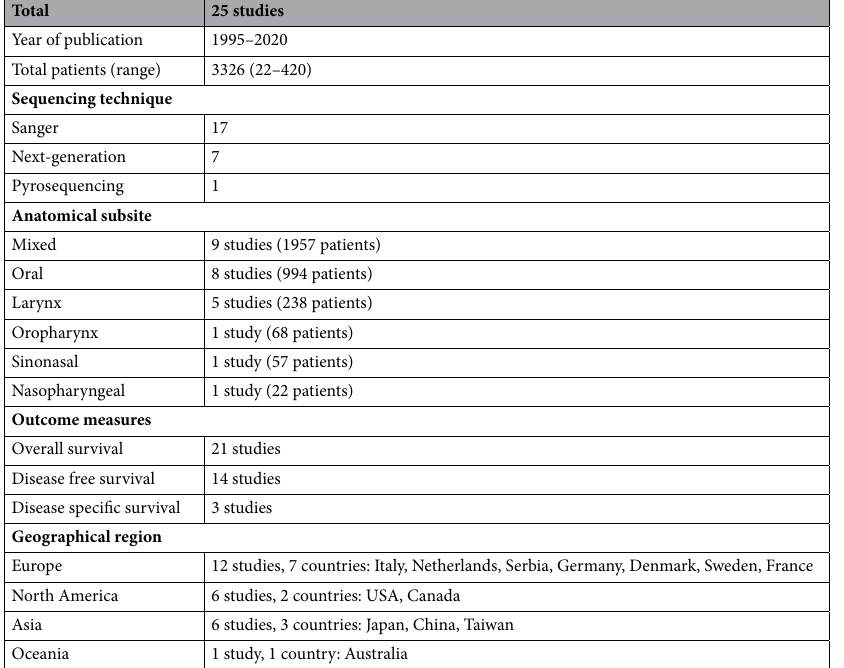
Table 1. Summarised characteristics of reviewed